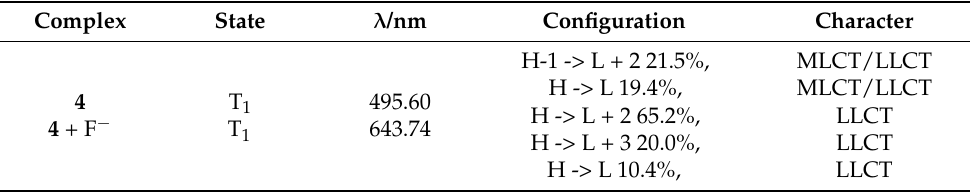
Table 2. The theoretical calculation of molecular orbitals of 4 and 4 + F − .